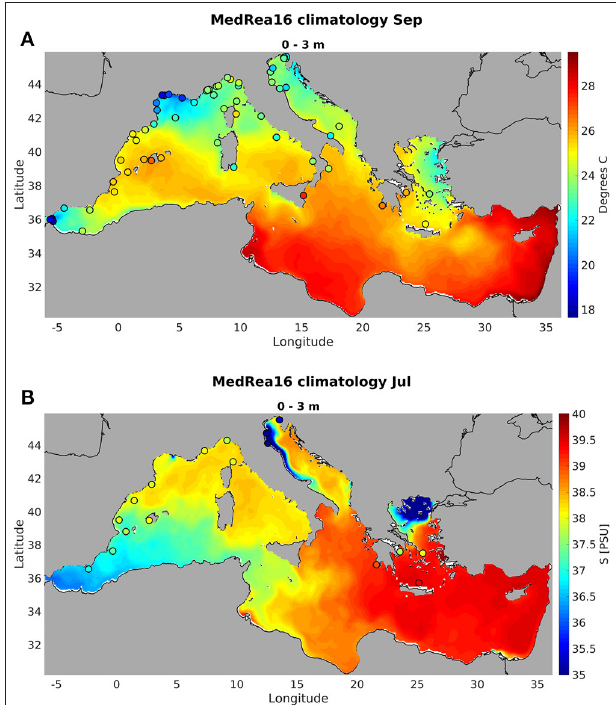
FIGURE 11 | Comparison between monthly climatologies from MED-NRT mooring time series in the layer 0–3 m (colored dots) and the surface fields of MedRea16 (approx. 1.4 m) computed in the time period 2013–2018: (A) temperature in September; (B) salinity in July. Only time series longer than 1 year are